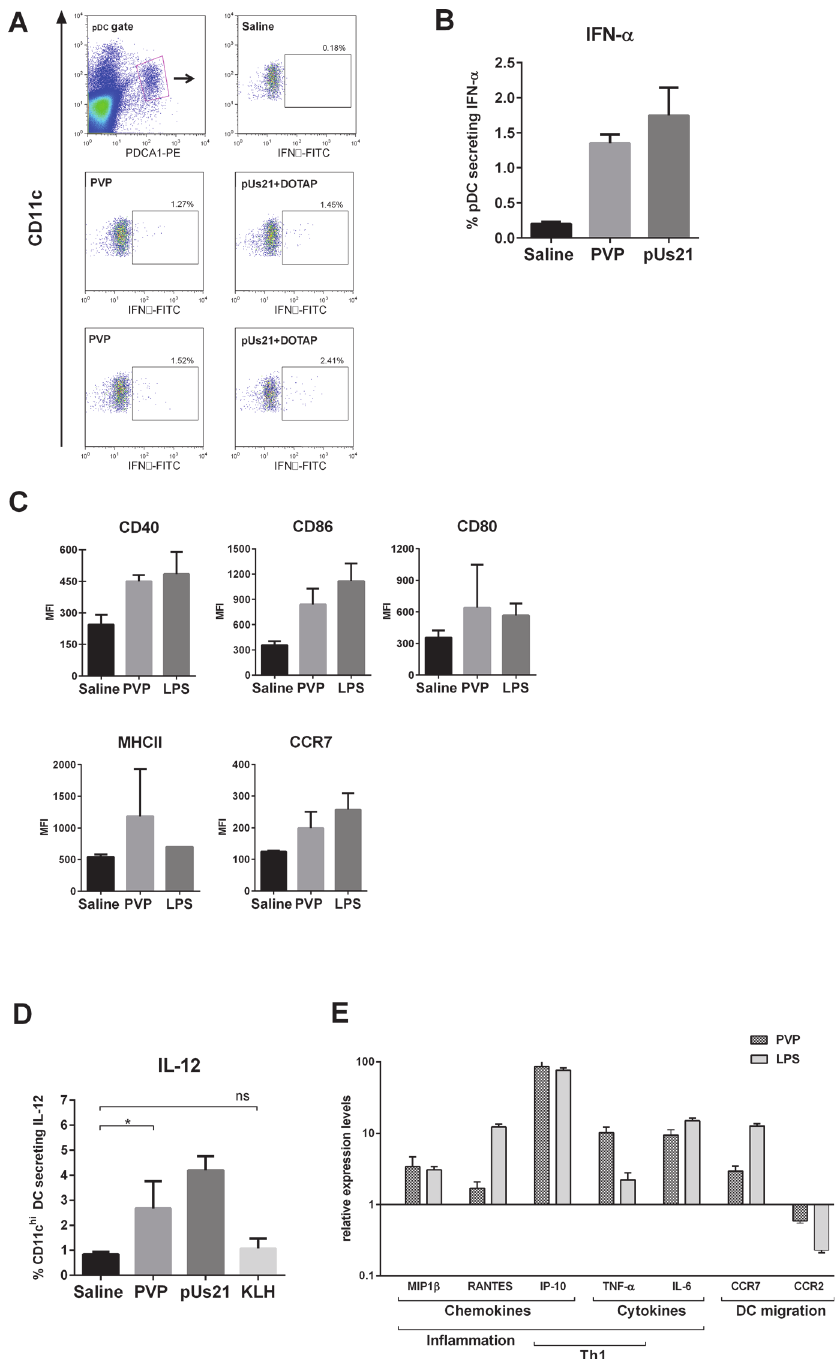
Fig 4. PVP activation of both plasmacytoid and conventional DC. (A) and (B) . Induction of IFN- α in pDC. Mice were injected i.v. with PVP, pUs21 ssRNA complexed with DOTAP (positive control) or saline and 4 h later spleens were harvested and IFN- α production detected in pDC by intracellular staining and flow cytometry. (A) . Representative flow cytometry plots from one of three independent experiments, showing CD11c int PDCA1+ pDC gating on B220+ cells. (B) . Mean values from two independent experiments, error bars show standard deviation. (C) . Mice were injected i.v. with PVP, LPS (positive control) or saline and spleens were collected after 24 h. Activation of conventional CD11c hi DC was evaluated by flow cytometry. MFI values from three mice are plotted with the error bars showing standard deviation. The data are representative of 3 independent experiments. (D) . IL-12 secretion by CD11c hi cDC 4 h after injection with